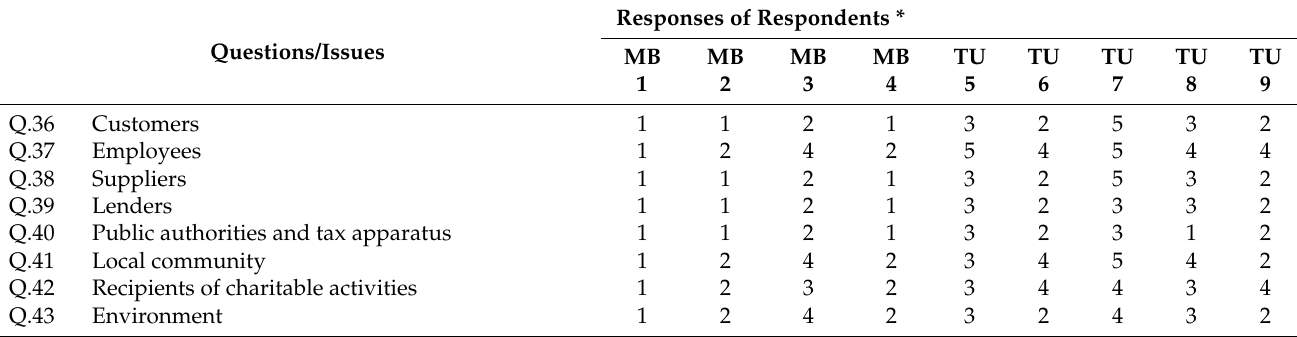
Table 3. Directions for improvement of ESG policy at the Opole Power Plant, taking into account the theory of